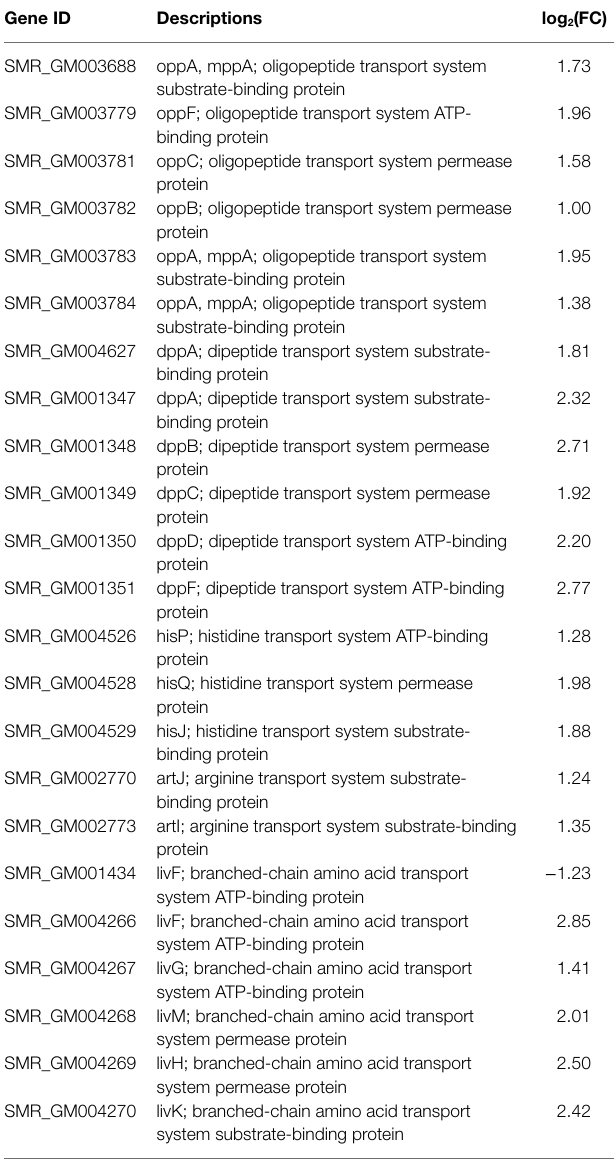
TABLE 6 | Differentially expressed genes involved in amino acid and peptide transport